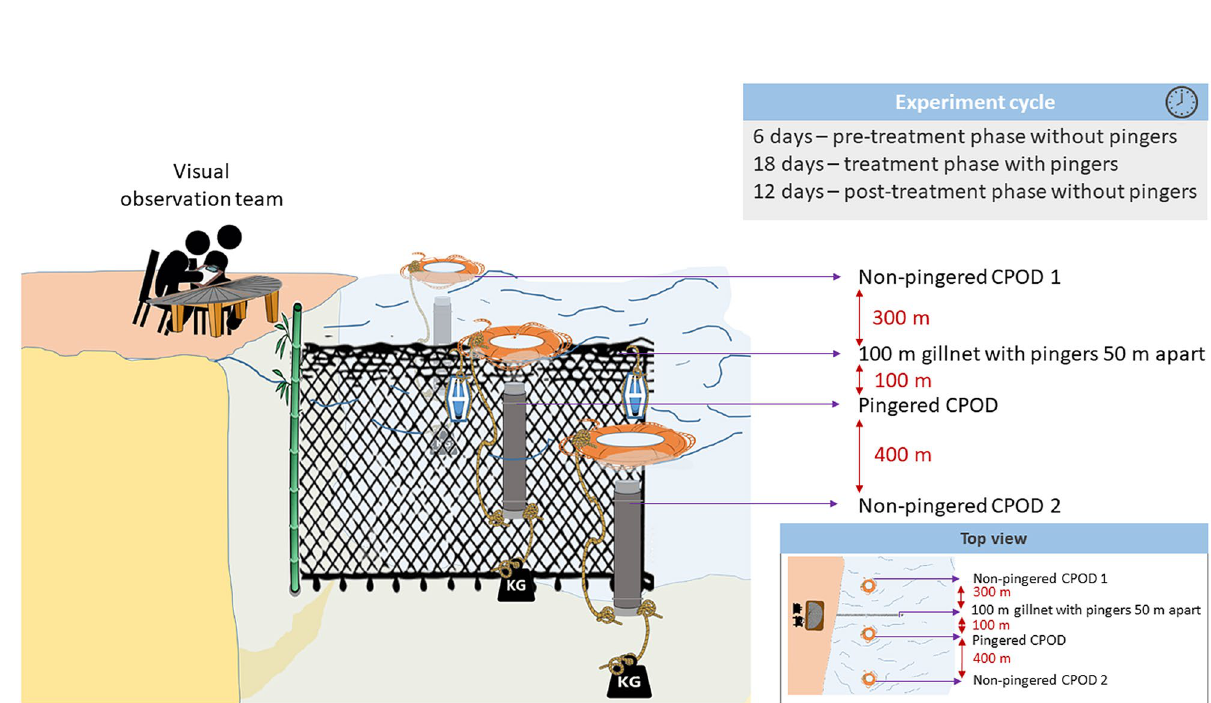
Figure 3. Experiment set up depicting the placement of CPODs, the net with pingers, visual team and the details of different phases of the experiment